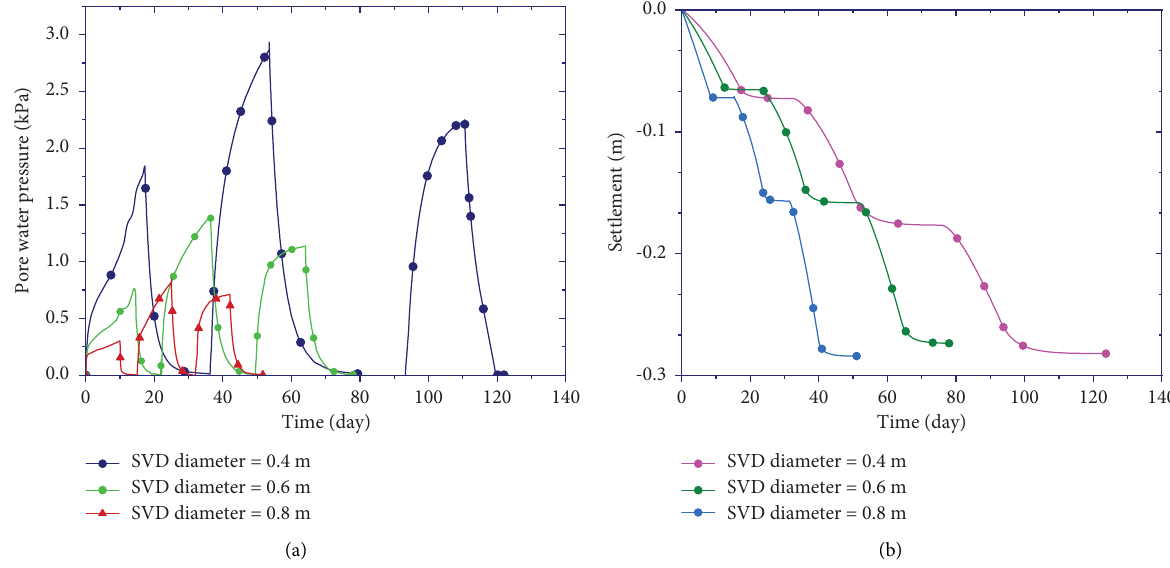
Figure 9: (a) Te efect of SVD diameter on pore water pressure (for S � 1.5 m and L � 15m). (b) Te efect of SVD diameter on settlement (for S � 1.5 m and L �